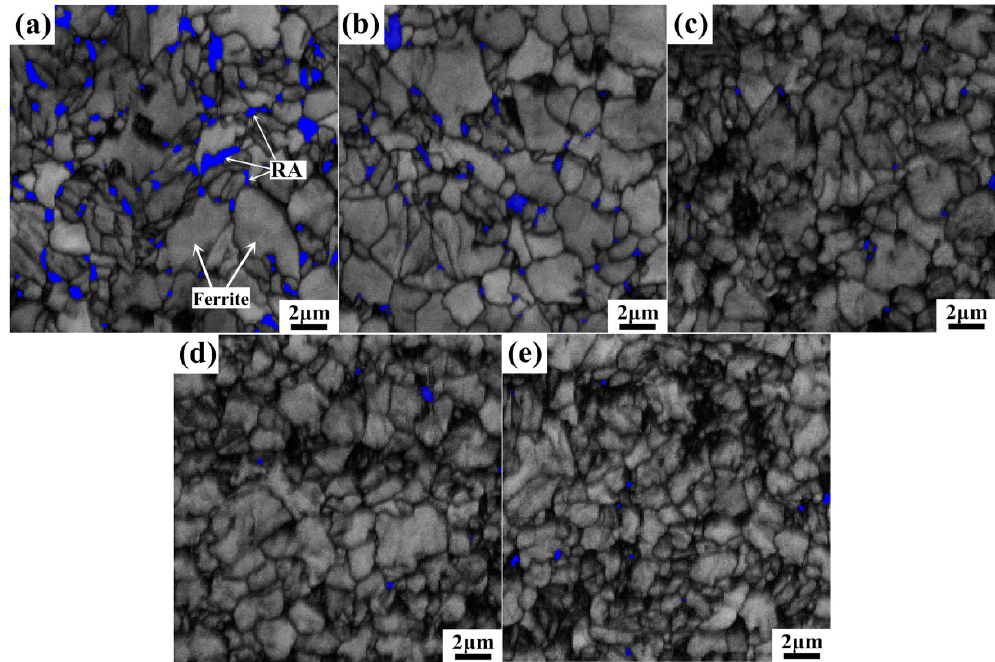
Figure 5. Representative EBSD maps showing face-centered cubic (FCC) phase (RA) and body-centered cubic (BCC) phase (ferrite, martensite, bainite) at different strain levels: ( a ) 0%, ( b ) 5%, ( c ) 10%, ( d ) 15%, ( e ) 20% (RA in blue, BCC phase in grey, high angle (>15°) grain boundaries in thick black lines, and low angle (<5°) grain boundaries in thin black lines).